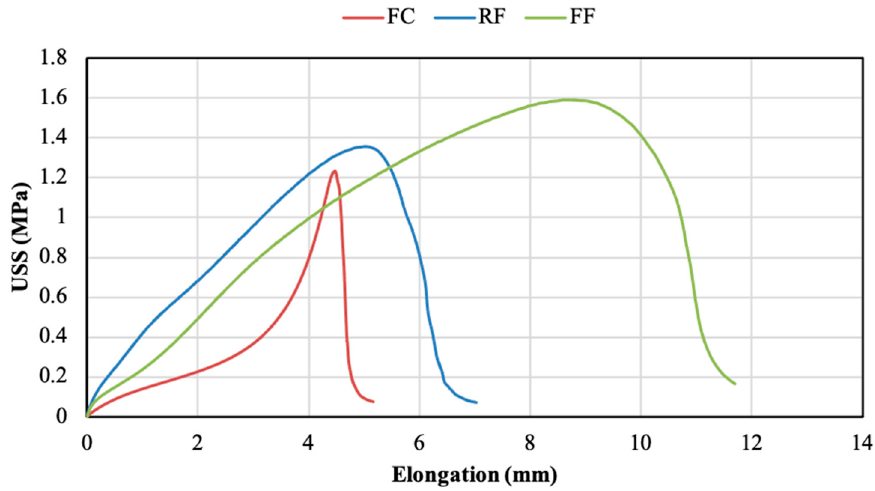
Figure 4. Characteristic shear stress–elongation curves of the 3